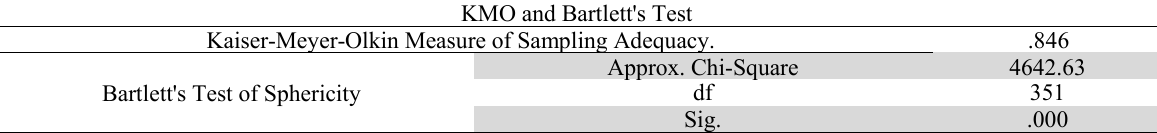
KMO and Bartlett’s Test of Sphericity